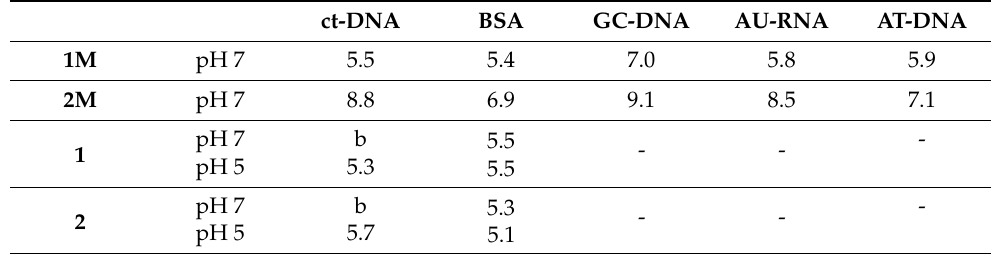
Table 2. Binding constants ( a log K s ) of 1 , 2 , 1M and 2M with ds-polynucleotides and BSA at pH = 7.0 or pH = 5.0, sodium cacodylate buffer, I = 0.05